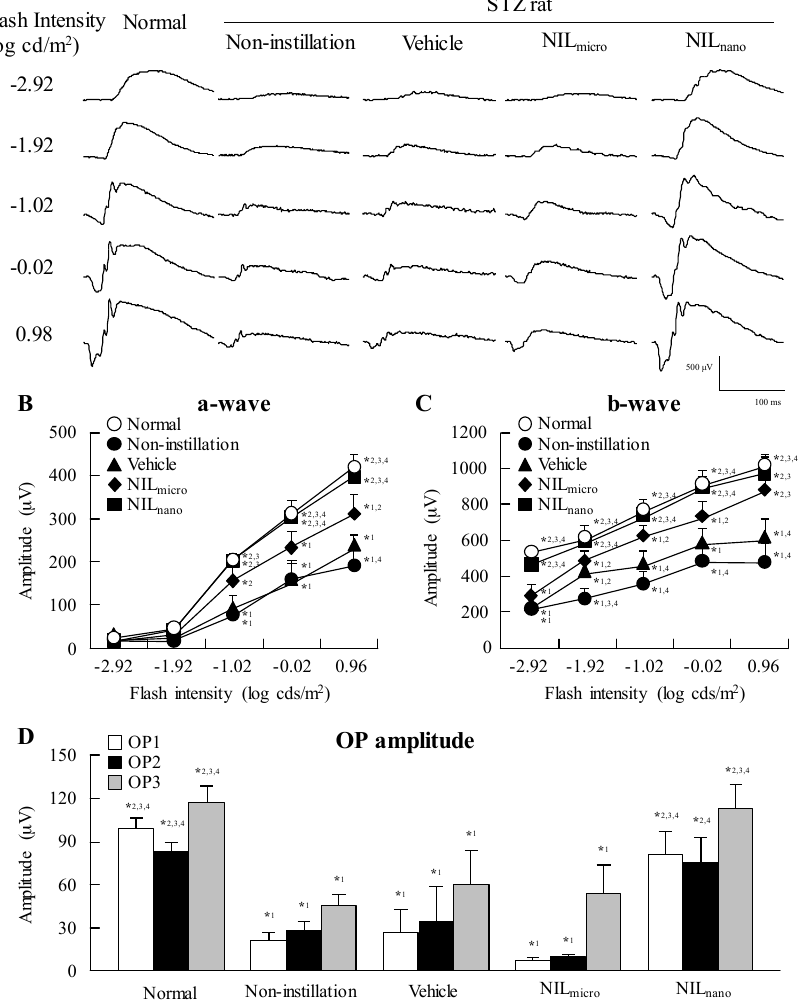
Figure 4. Typical traces of ERG ( A ); a-wave ( B ); b-wave ( C ); and OP amplitude ( D ) in STZ rats after the instillation of NIL nano . One percent NIL were instilled for two weeks (twice a day, 9:00 a.m. and 7:00 p.m.). Open symbols, normal rats; closed symbols, STZ rats. Normal, non-instilled normal rats; Non-instillation, non-instilled STZ rats; Vehicle, vehicle-instilled STZ rats; NIL micro , NIL micro -instilled STZ rats; NIL nano , NIL nano -instilled STZ rats. n = 5–7. * 1 p < 0.05, vs. normal group for each category. * 2 p < 0.05, vs. non-instillation group for each category. * 3 p < 0.05, vs. vehicle group for each category. * 4 p < 0.05, vs. NIL micro group for each category. The retinal dysfunction of STZ rats was attenuated by the instillation of NIL nano .